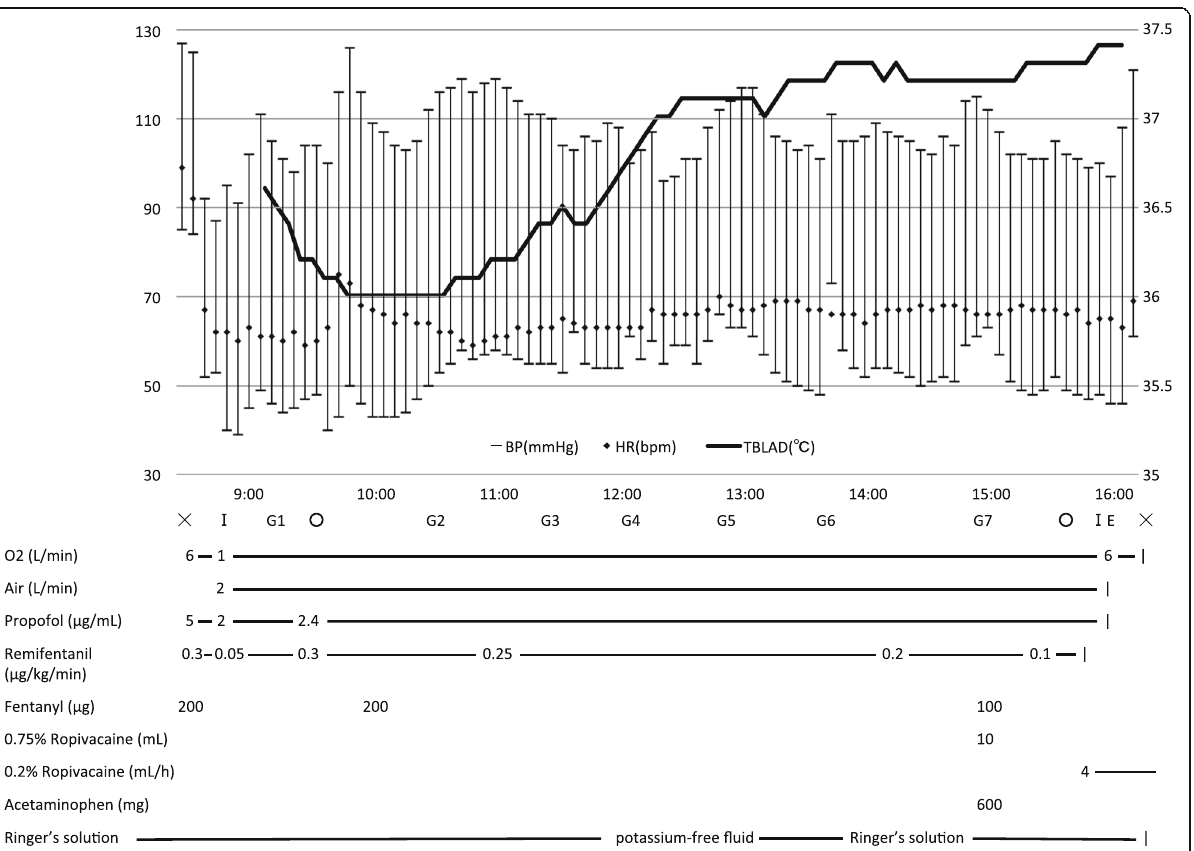
Fig. 1 Anesthesia record of the present case. BP, blood pressure (left axis); E, extubation; G1 – 7, the time points of arterial blood gas analysis; HR, heart rate (left axis); I, intubation; TBLAD, urinary bladder temperature (right axis); ×, start and end of the anesthesia; ○ , start and end of the